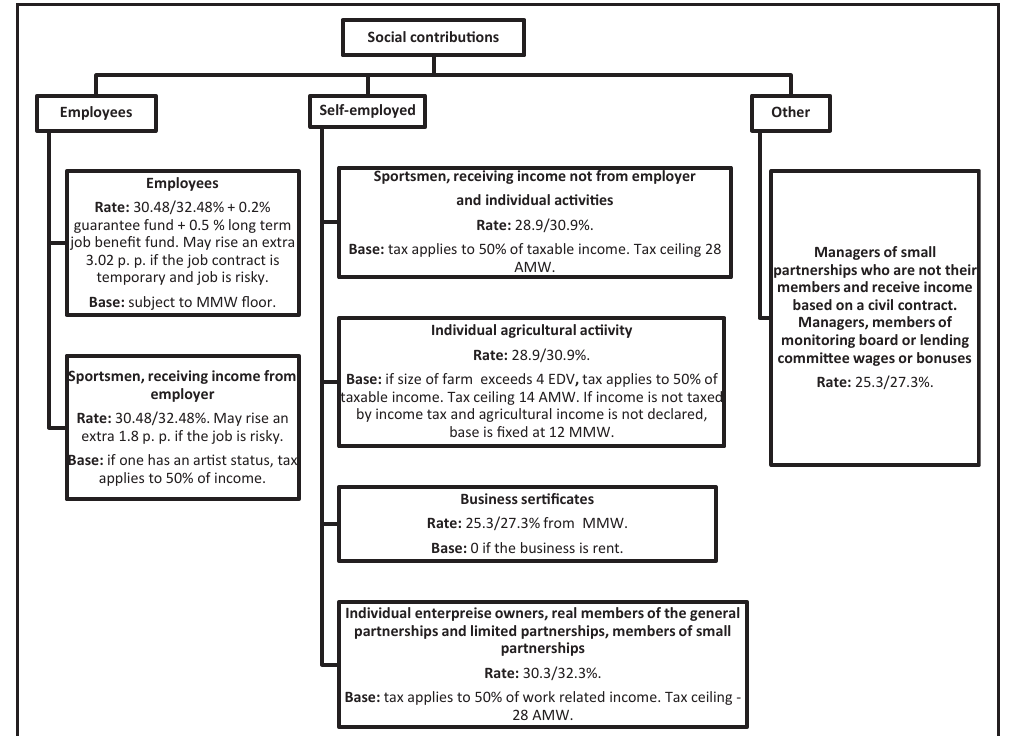
Statutory social insurance contributions excluding the statutory health insur- ance contributions prior to 2019 reform. Social contribu ti